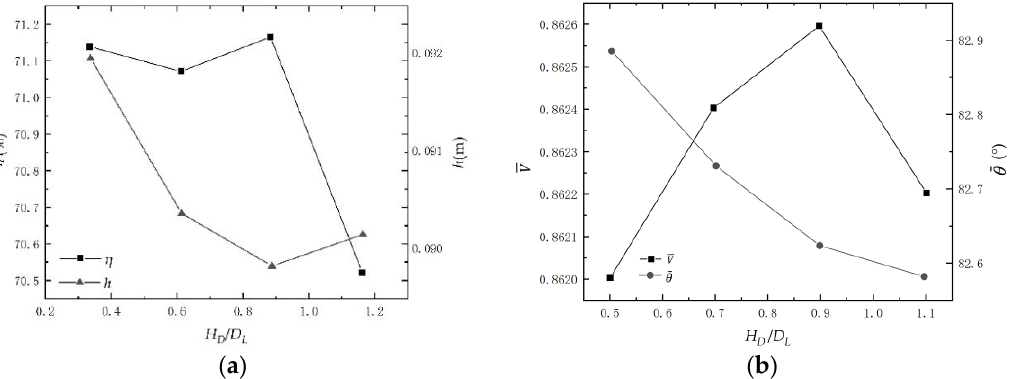
Figure 10. Hydraulic characteristics with different top floor height. ( a ) Pump efficiency and hydraulic loss and ( b ) Velocity uniformity and weighted average angle of exit velocity.